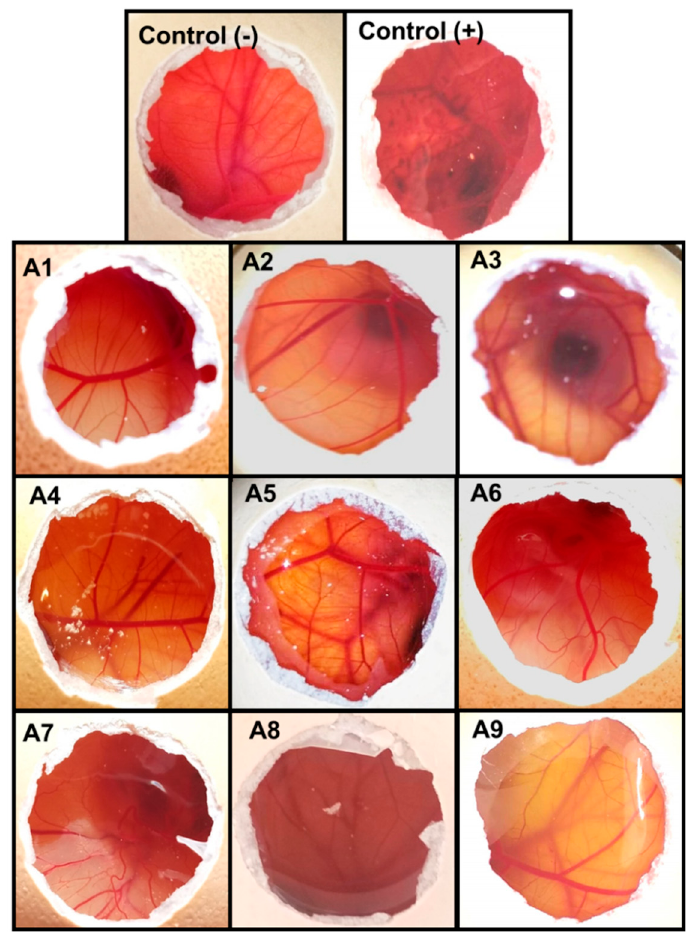
Figure 4. Pictures of Hen's Egg Test-Chorioallantoic Membrane (HET-CAM) test recorded after five minutes of contact with nepafenac formulations. Negative and positive controls refer to 0.9% NaCl and 0.1 N NaOH, respectively.